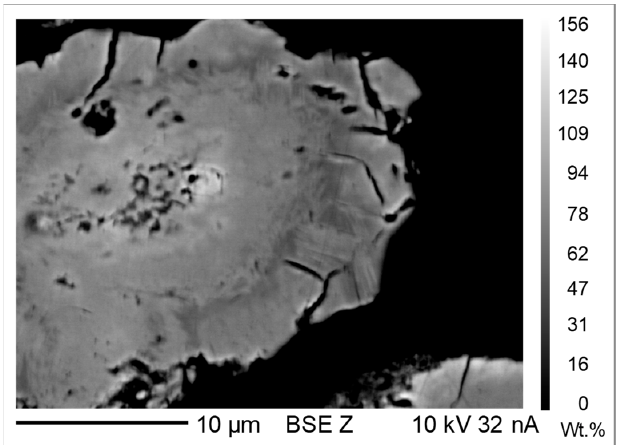
Figure 5. Backscattered electron micrograph (BSE(Z)) of the mineral phase containing up to 10.4 wt% thorium.